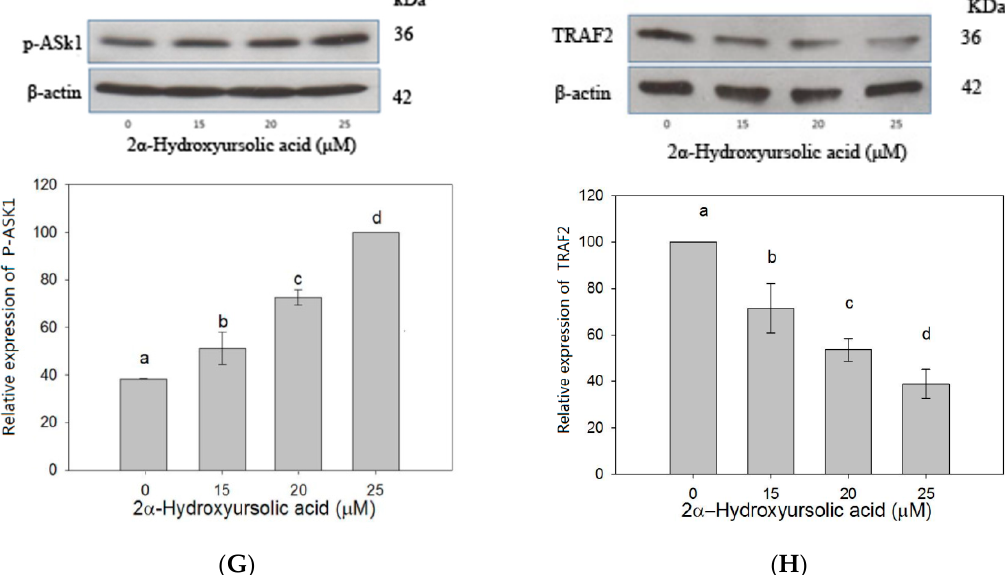
Figure 4. Effects of BA, Rh 2 and the combination of BA and Rh 2 on expression of p-p53 ( A , E ), p-p38 ( B , F ), p-ASK1 ( C , G ), and TRAF 2 ( D , H ) in MDA-MB-231 and MCF-7 human breast cancer cells. Bars with no letters in common are significantly different ( p < 0.05). Each value represents the mean ± SD of triplicates. Different letters showed significant difference in sample groups ( p < 0.05).